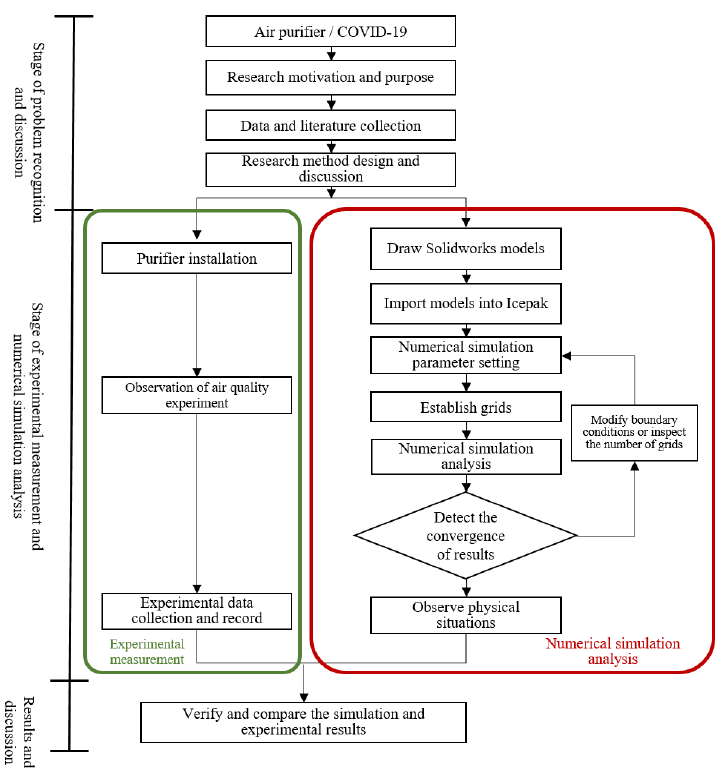
Figure 1. Air purifier research process and architecture.